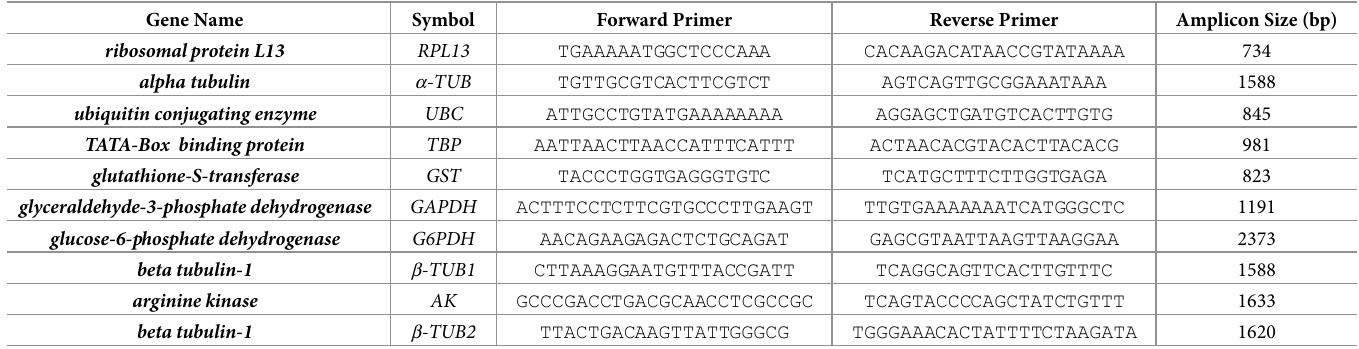
Table 2. Sequence information of the Candidate Reference